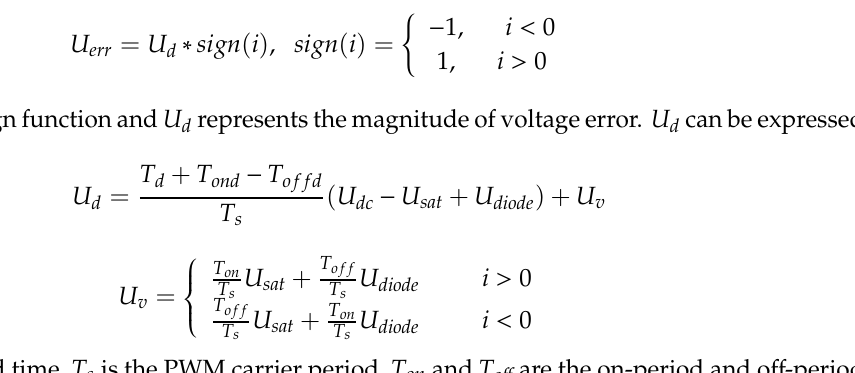
Figure 4. Switching patterns and output voltages. ( a ) Phase current is positive. ( b ) Phase current is negative.